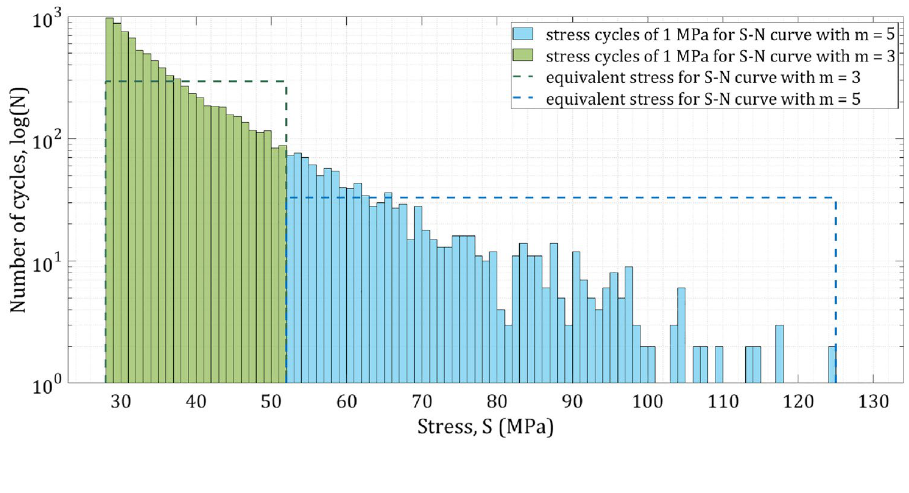
Table 1 Values of return level for daily number of fatigue cycles C ( 1 ) and C ( 2 )